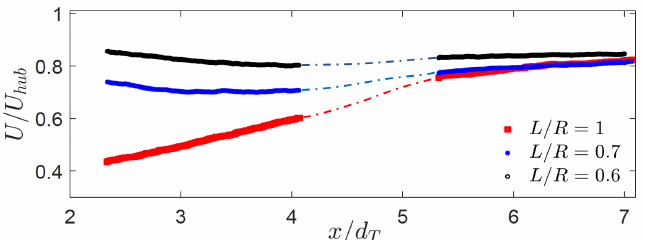
Figure 6. Mean velocity distributions U / U hub along the turbine rotor axis (hub height) for the rotors with L / R = 0.6, 0.7, and